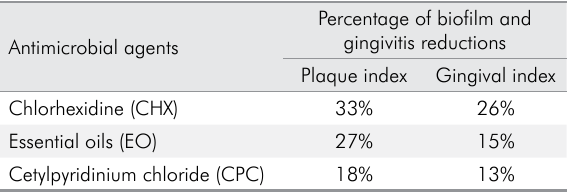
Table. Percentage of biofilm and gingivitis reduction according to antimicrobial